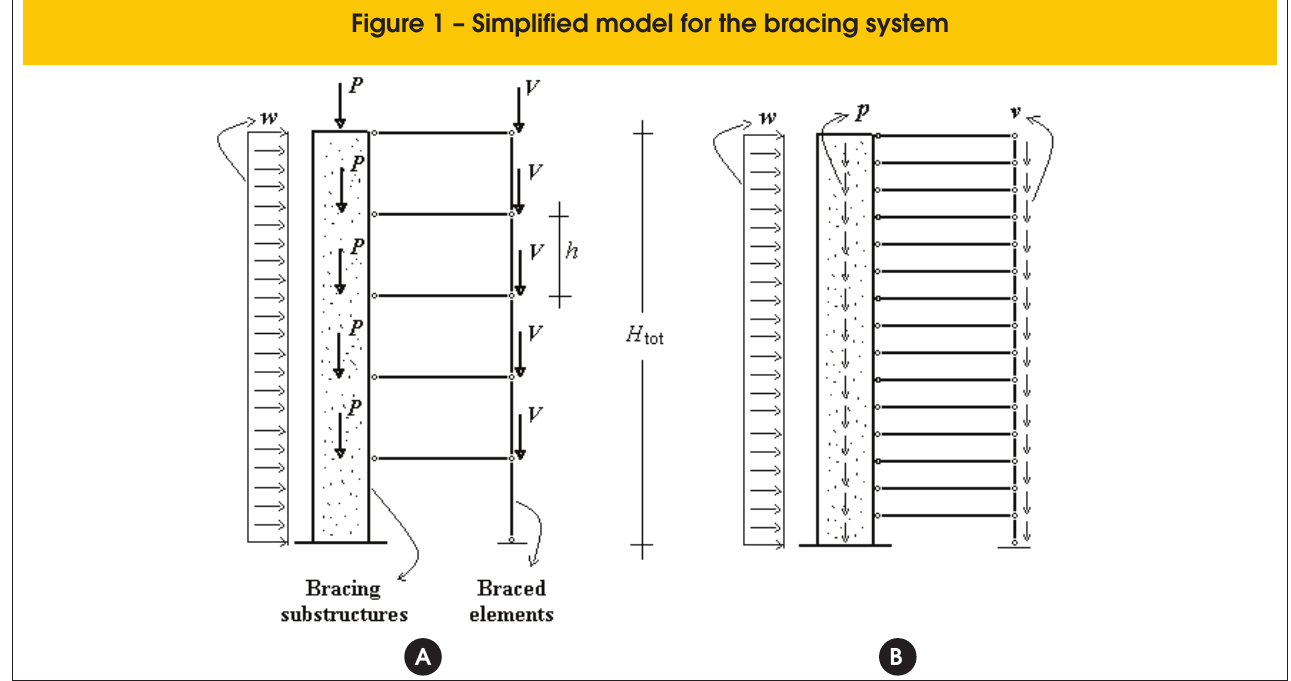
Figure 1 – Simplified model for the bracing